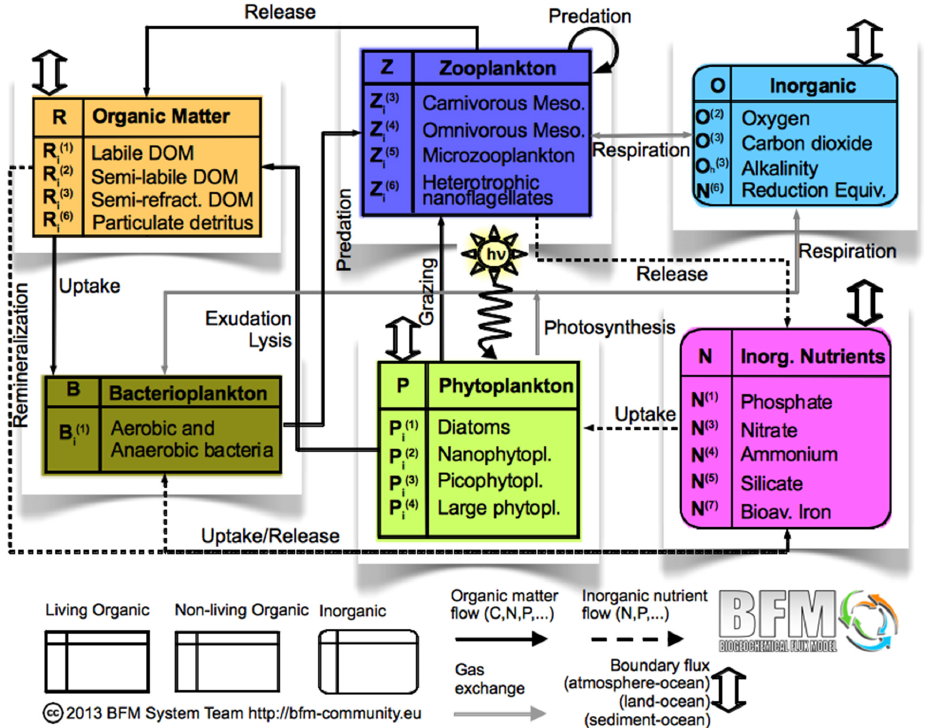
Fig. 11. State-of-the-art biogeochemical model schematics. The biogeochemical flux model is used extensively in Mediterranean biogeo- chemical studies. It describes the trophic interactions of the marine ecosystems by describing the cycles of the organic and inorganic carbon as well as the macro-nutrients. Major features are the plastic intracellular N:P:Si:C:Chl a ratios and the explicit description of the micro- bial